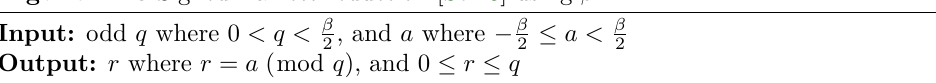
Algorithm 8 Signed Barrett reduction [Sei18] using β = 2 16 .